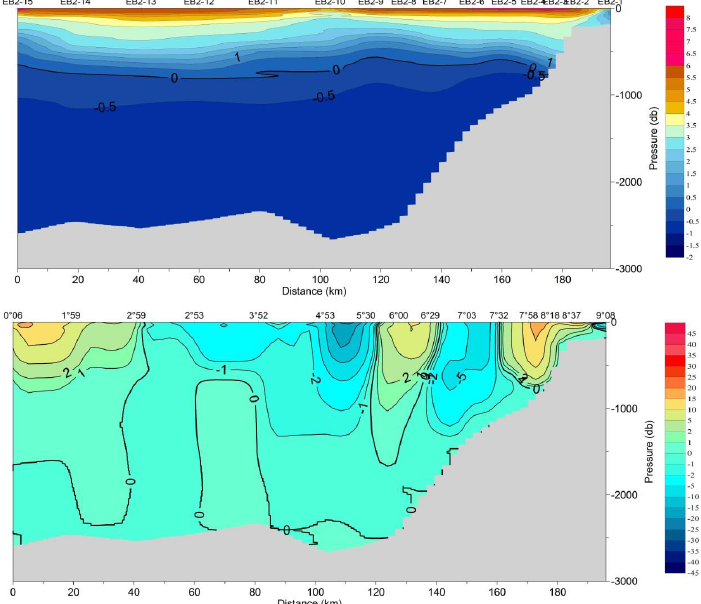
Fig. 20. Temperature and baroclinic velocity at section EB along 78 ◦ 50 0 N, between longitudes 0 ◦ 06 0 E–9 ◦ 08 0 E. R/V Oceania , summer Figure 20. Temperature and baroclinic velocity at section EB along 78°50’N, between 4